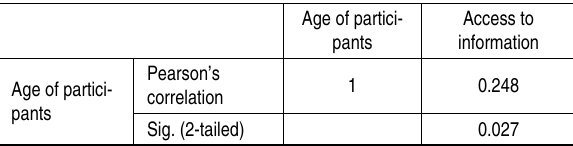
Table 4. Age versus access to